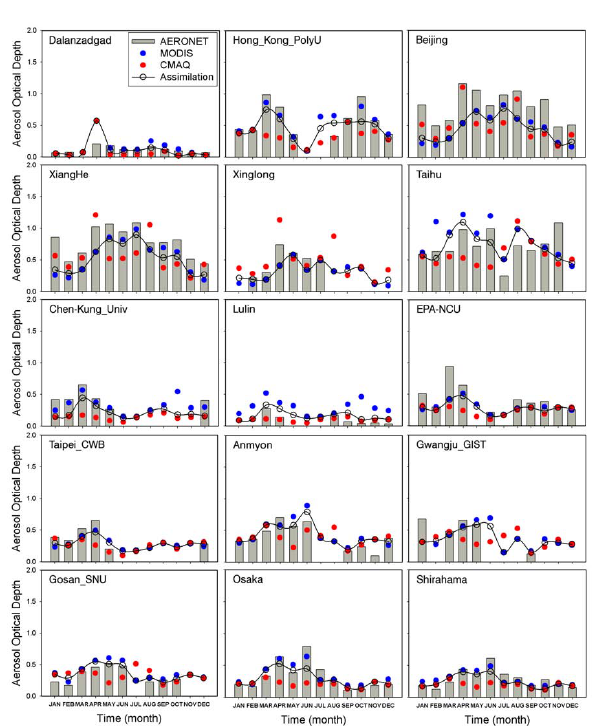
Fig. 11. Monthly variations in the MODIS-retrieved, CMAQ- simulated, assimilated and AERONET AODs at 15 AERONET sites over East Asia for 2006. Grey bars, blue circles, red circles and black solid lines represent AODs obtained from AERONET, MODIS, CMAQ and assimilation,